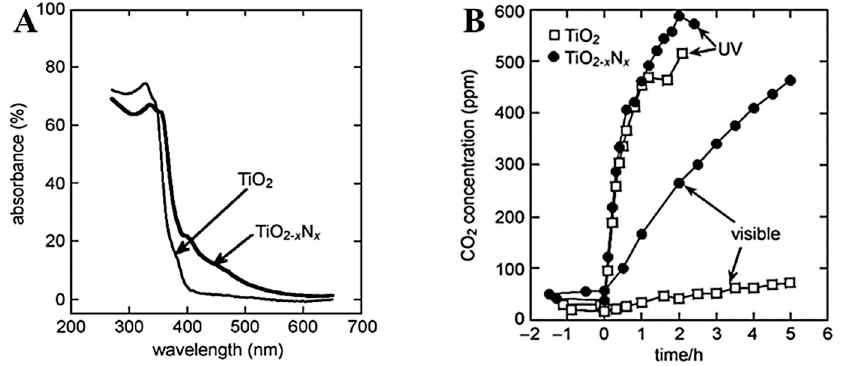
Figure 7. ( A ) UV-Vis spectra of TiO 2-x N x and TiO 2 and ( B ) the photocatalytic property of